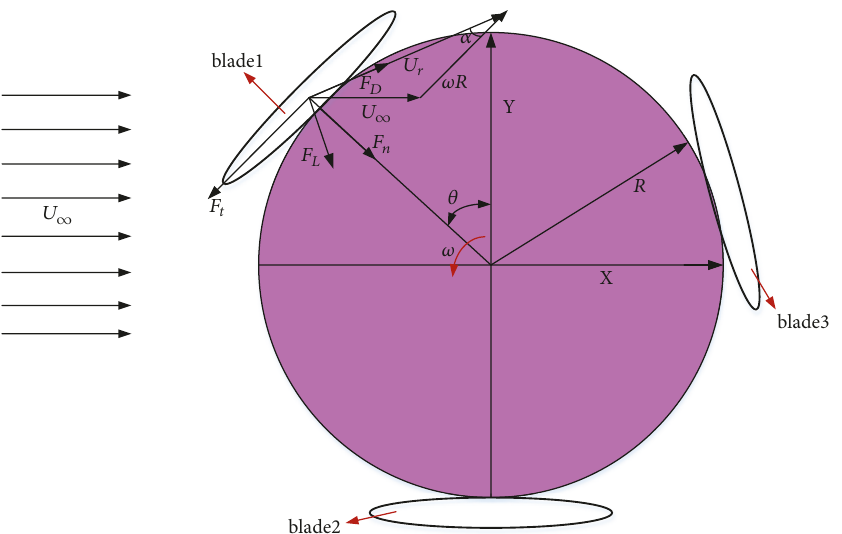
Figure 1: The schematic of the H-VAWT